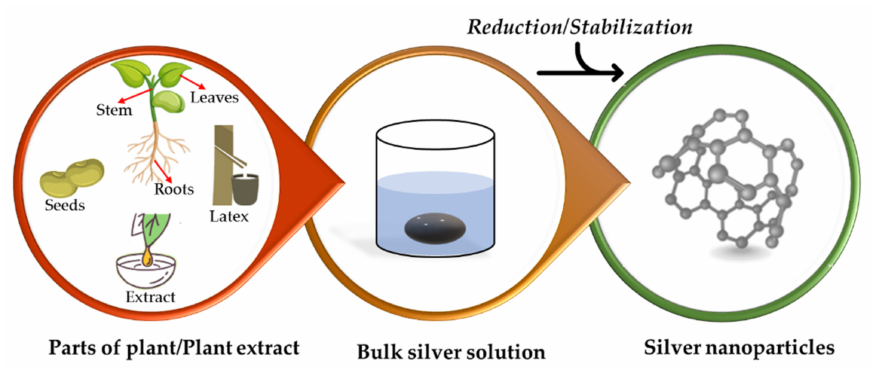
Figure 6. Overview of steps of synthesize mediated by plant or plant extract (adapted from Nadeem et al.